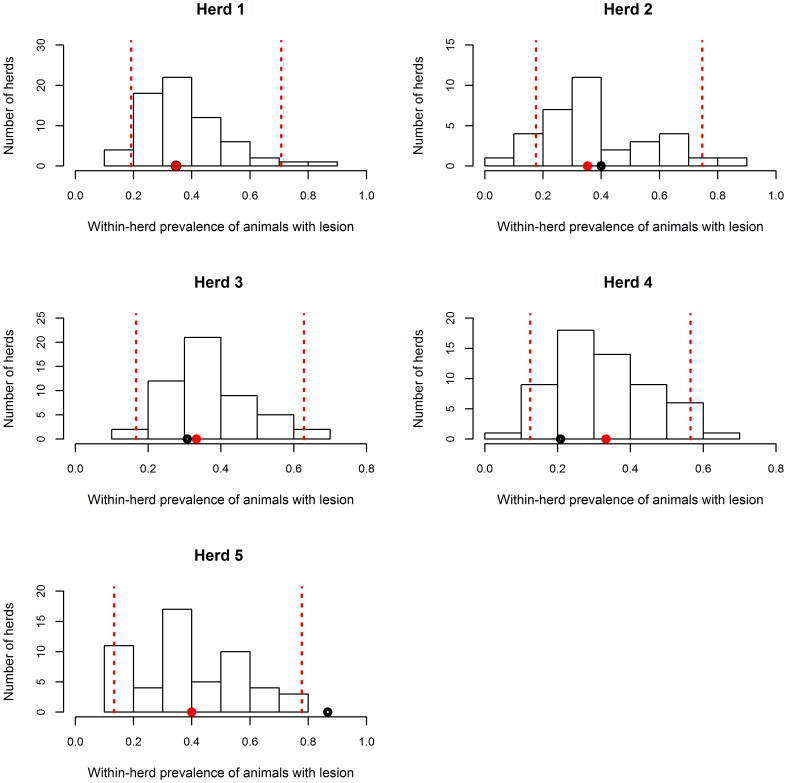
Observed and simulated proportions of animals with detected lesions when total slaughter is performed, for the 5 herds of dataset A.Black point: observed proportion of animals with bTB-like lesions in each herd; red point: simulated median proportion of animals with bTB-like lesions in each herd; dotted lines: 2.5% and 97.5% percentiles of the simulated distributions.